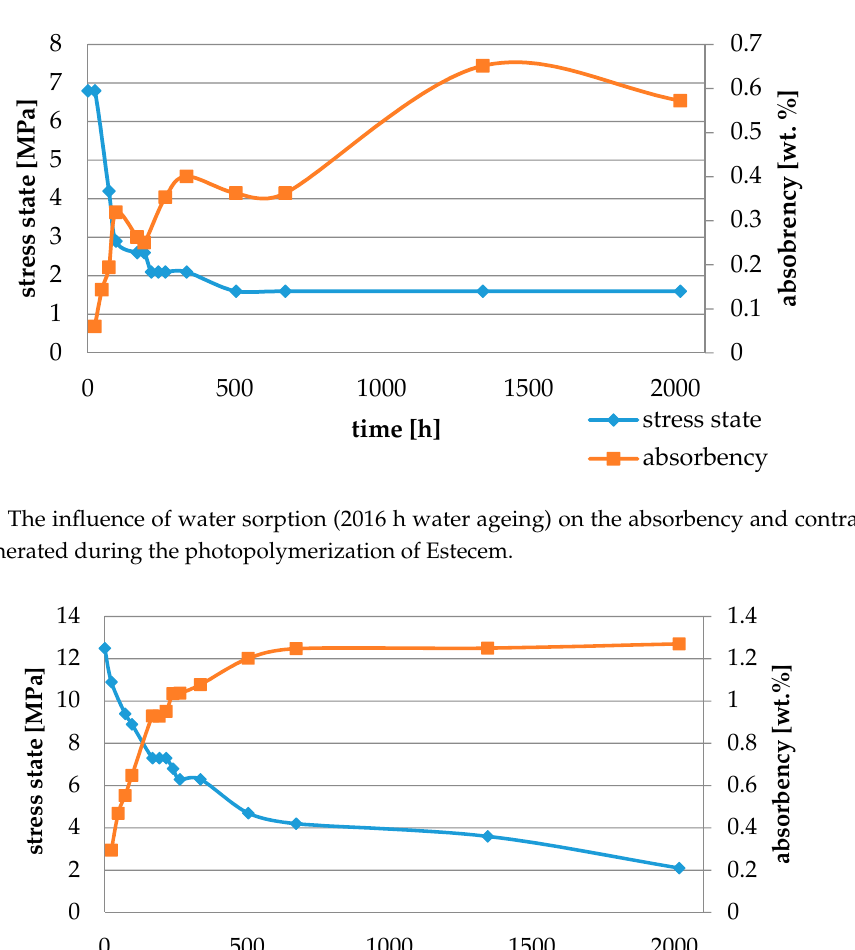
Figure 4. The influence of water sorption (2016 h water ageing) on the absorbency and contraction stress generated during the photopolymerization of Variolink Esthetic DC.